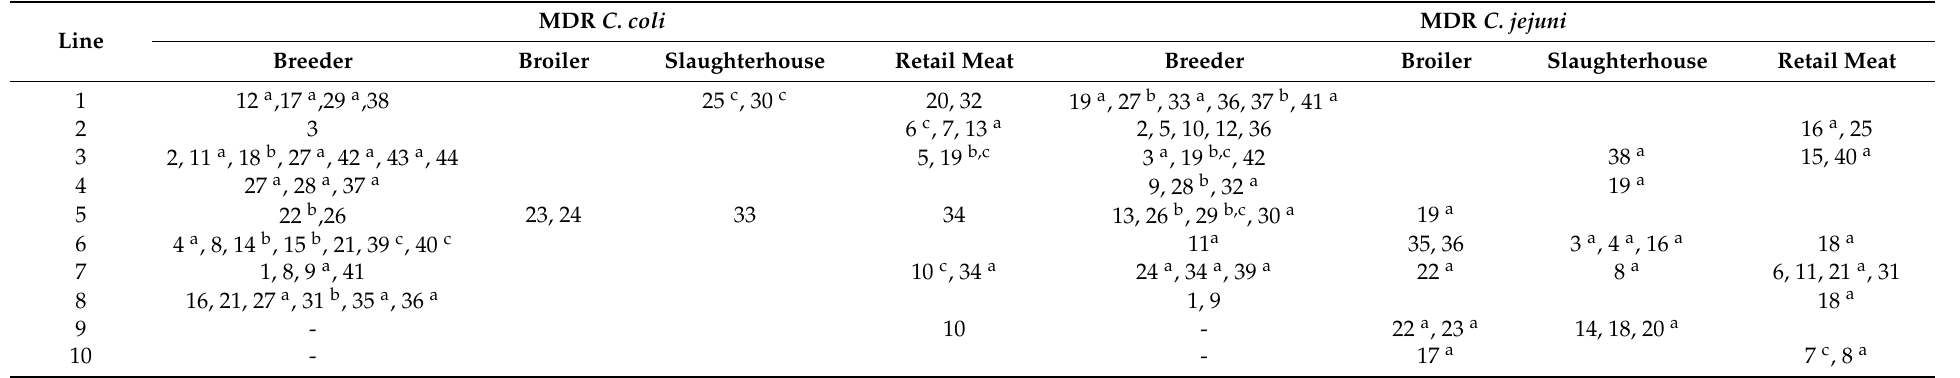
Table 4. Pulsed-field gel electrophoresis type of multi-drug resistant (MDR) Campylobacter coli and C. jejuni isolates from different lines along the chicken production chain.